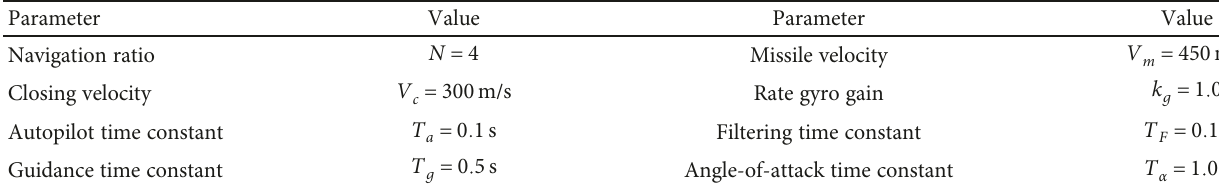
Table 3: Typical fl ight parameters of